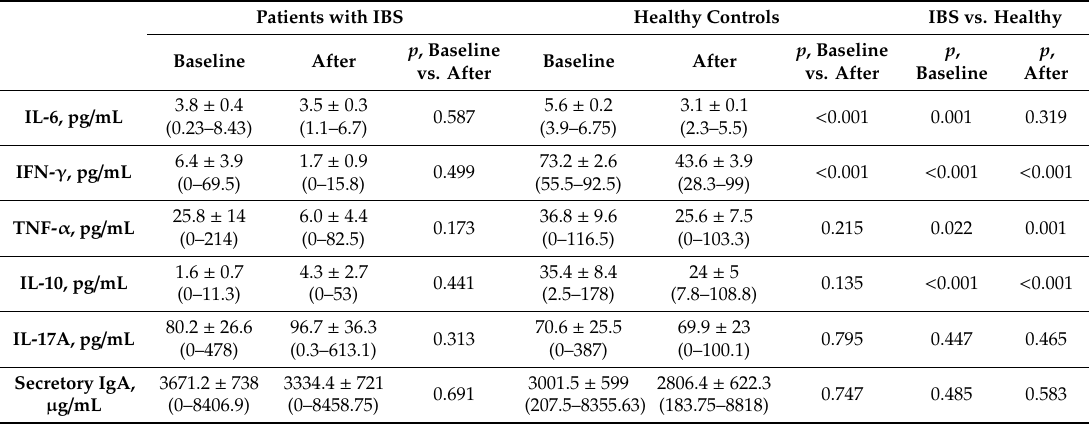
Table 2. Cytokines and IgA levels in fecal samples of healthy controls and patients with irritable bowel syndrome (IBS) at baseline and after supplementation of a product comprising lactobacilli supplemented with larch arabinogalactan and colostrum.